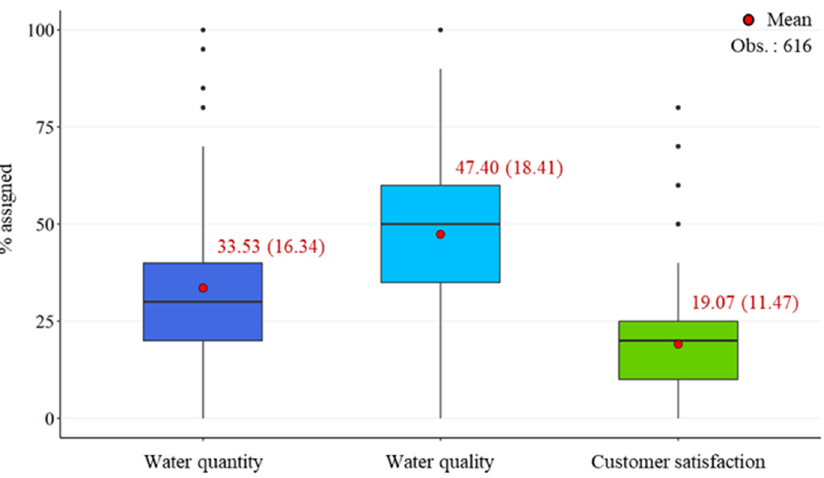
Figure 4. Respondents’ willingness to assign increased revenue due to an increased water bill to different services: water quantity (Perc_SUS), water quality (Perc_WQ), and customer satisfaction (Perc_SER).